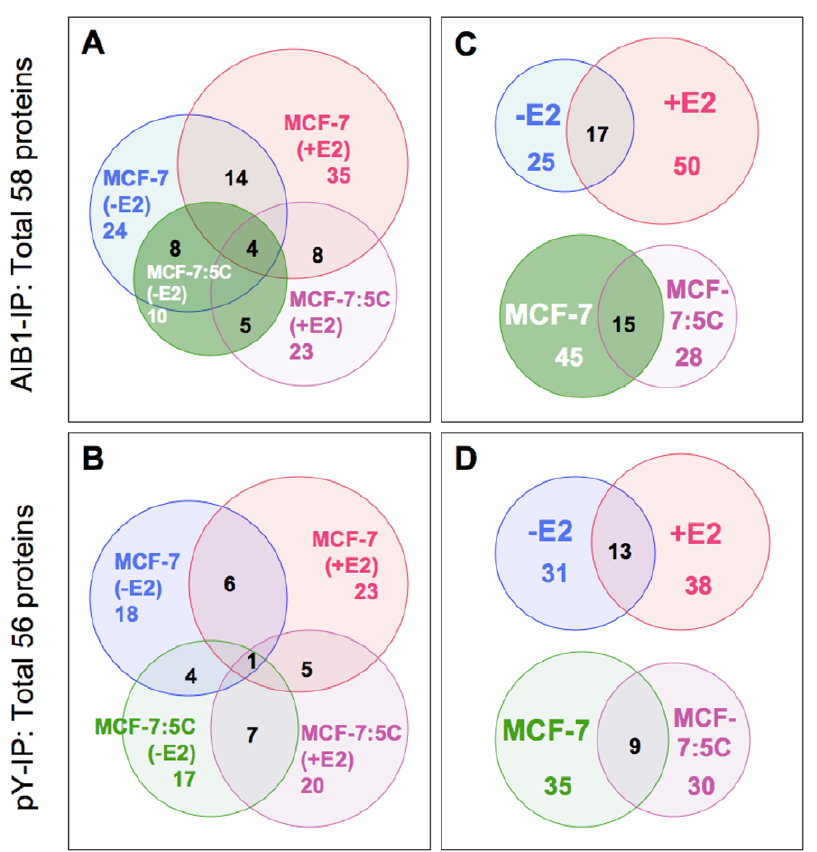
Figure 2. Summary of proteins identified under different conditions. Venn diagrams of proteins identified from anti-AIB1 ( A,C ) or anti-pY IP ( B,D ) experimental groups. ( C,D ) Proteins in combined AIB1-IP or pY-IP data sets. Individual proteins and subgroups are shown in Tables S1 & S2.